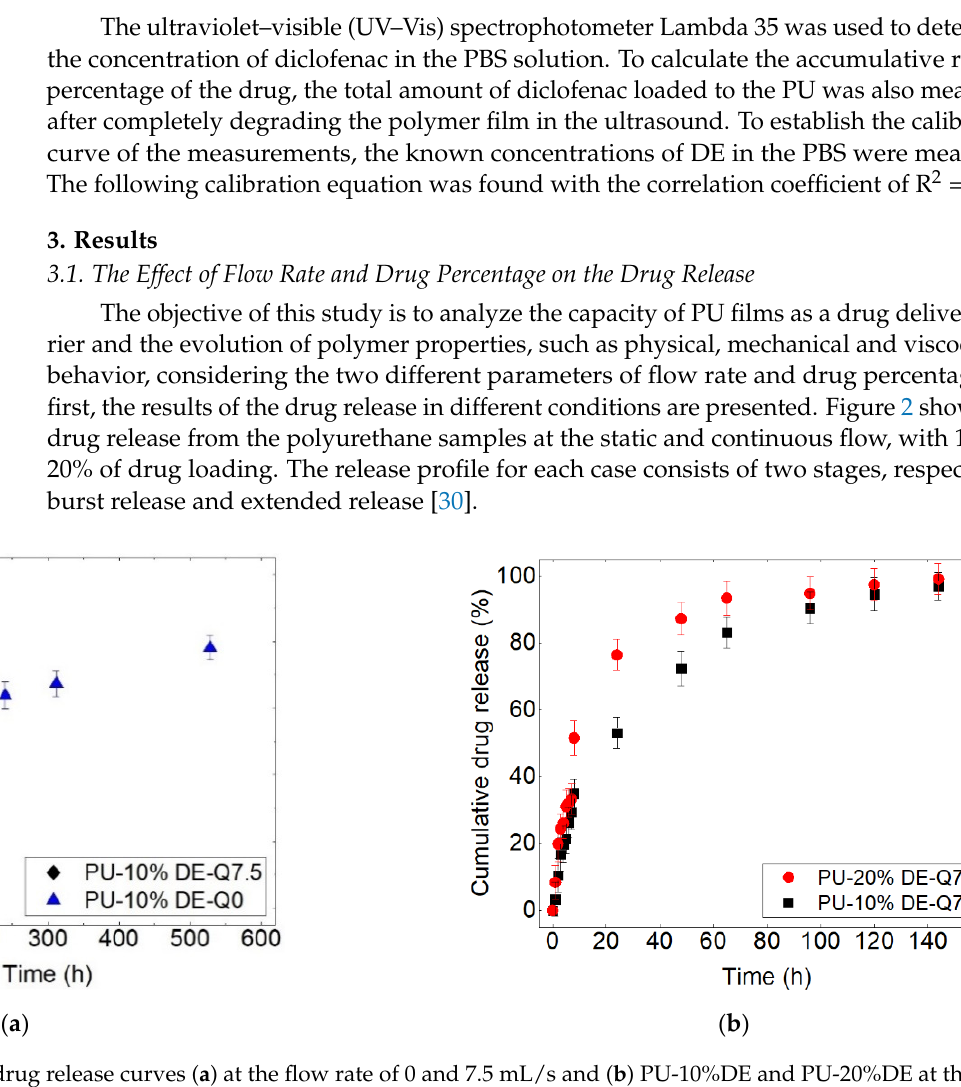
Figure 2. Cumulative drug release curves ( a ) at the flow rate of 0 and 7.5 mL/s and ( b ) PU-10%DE and PU-20%DE at the flow rate of 7.5 mL/s (PU-10%-DE-Q7.5: polyurethane-10% diclofenac epolamine—flow rate of 7.5 mL/s).